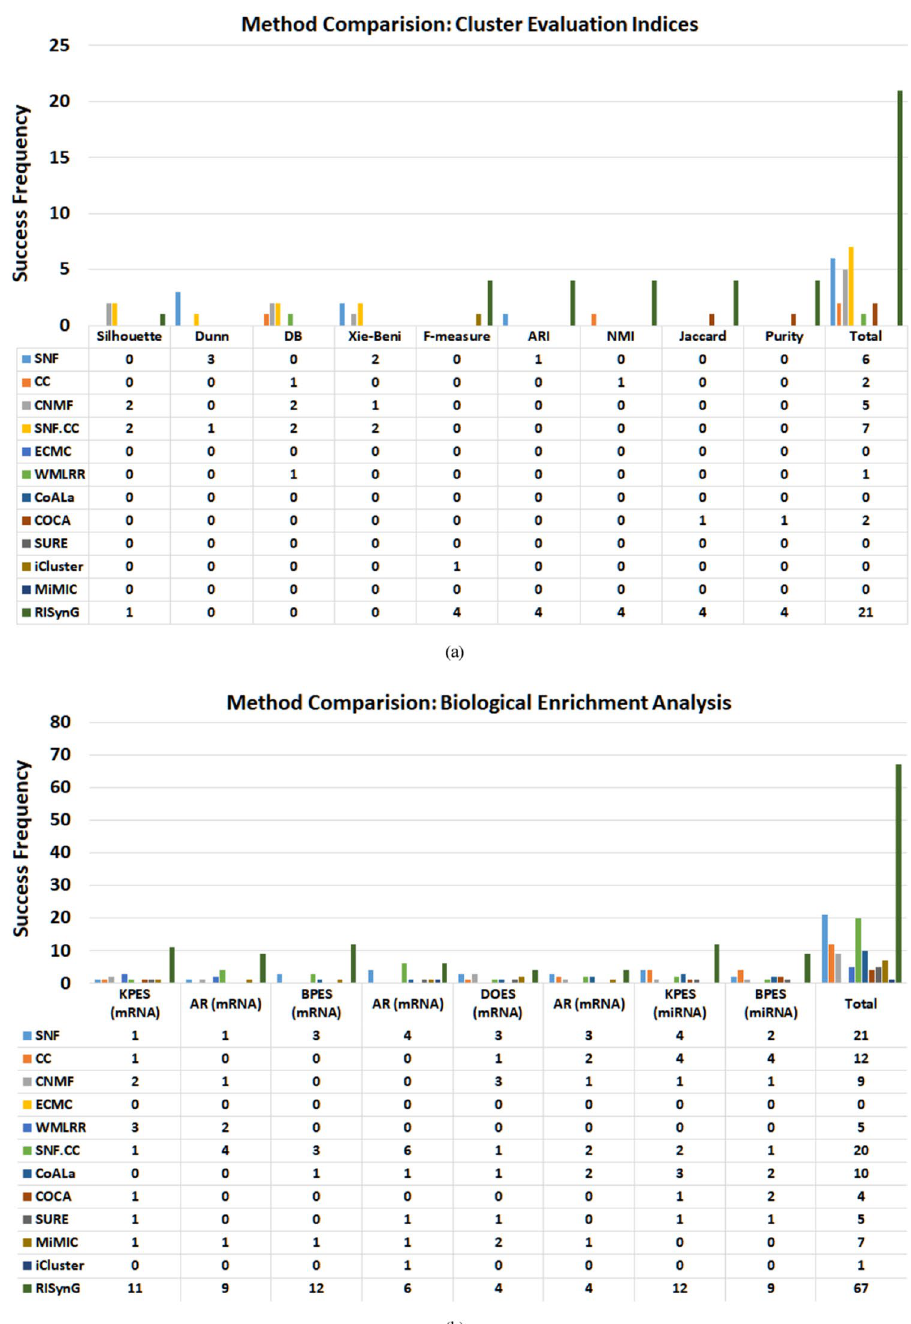
Figure 8. Method